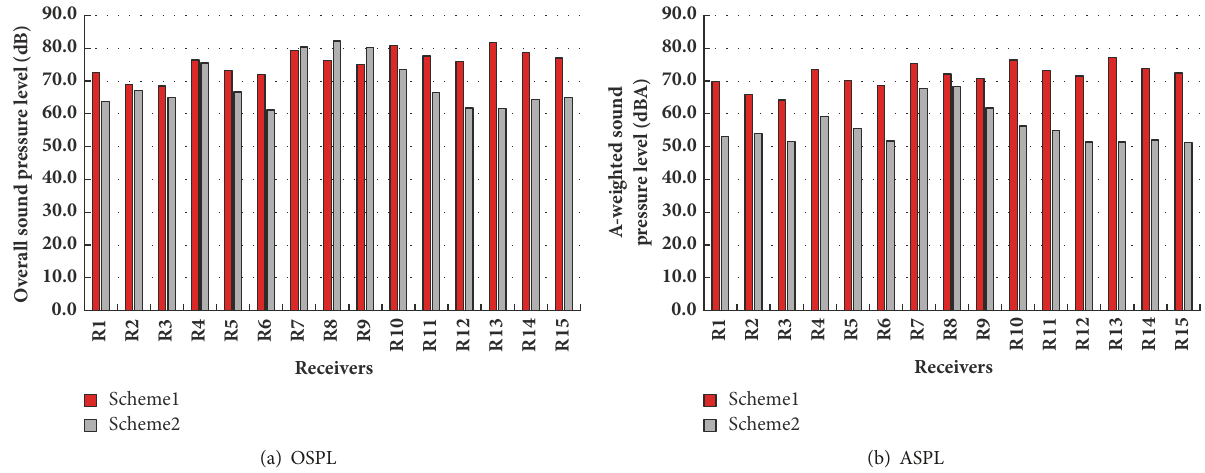
Figure 9: Comparison with sound pressure level of each receiver for the maximum wind speed condition at 1-year return